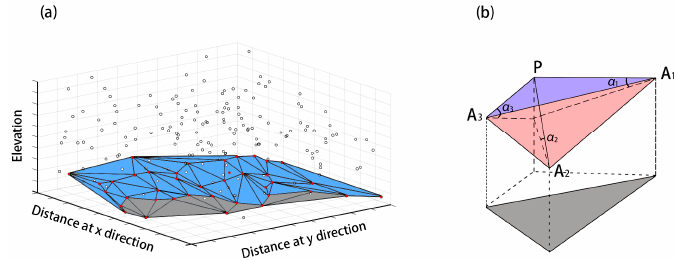
Figure 3. The schematic diagram of morphology-based DTM generation method. ( a ) Some of the lowest points are selected as preliminary ground points and form a coarse TIN; ( b ) Rest points are examined using triangles within this TIN